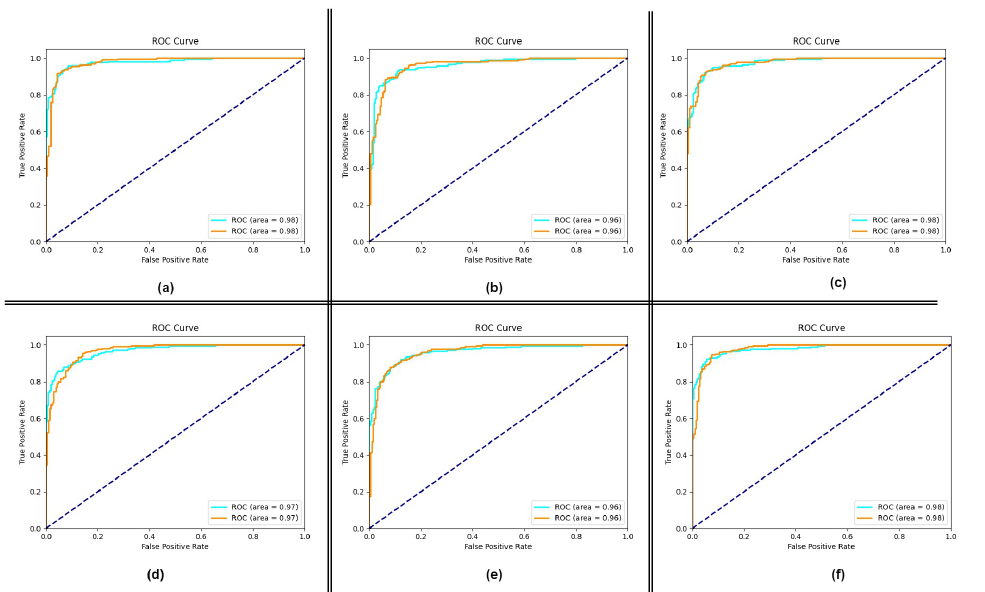
Figure 6. The result of ROC curves obtained from different folds in our proposed model ( a ) shows the roc curve obtained from fold-1, ( b ) fold-2 roc curve, ( c ) fold-3 roc curve, ( d ) fold-4 roc curve, ( e ) fold-5 roc curve, and ( f ) fold-6 roc curve for the classification of ALL cell images.